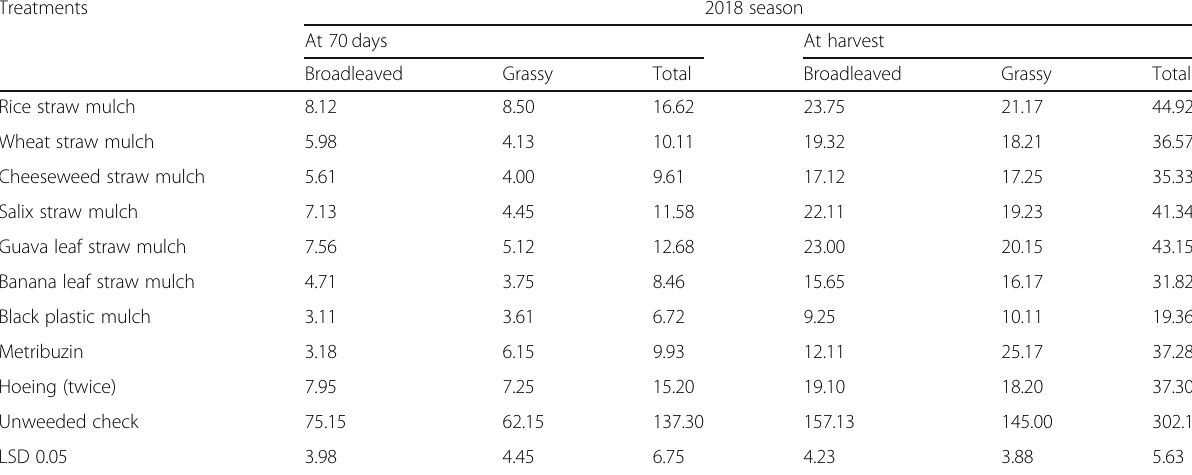
Table 2 Effect of different weed control treatments on dry weight of associated potato weeds (g/m 2 ) after 70 days from planting and at harvest during 2018 season